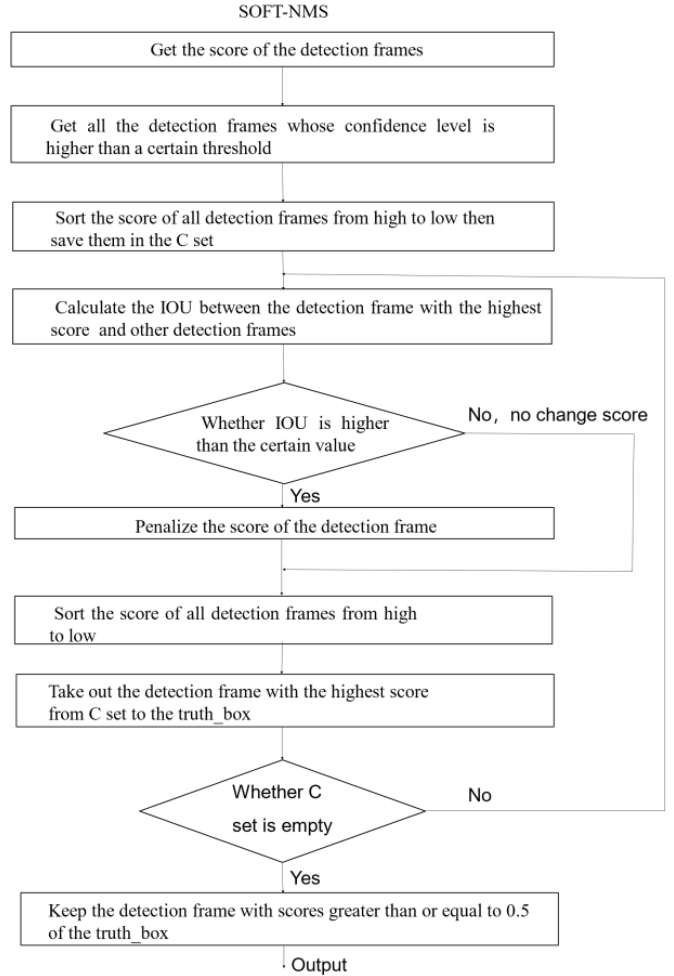
Figure 3. The flow chart of Soft-NMS. In summary, the main idea of Soft-NMS is as follows. Firstly, it finds out all the detection frames which have a higher confidence level than a certain artificial-set confidence level from an image. The circumstance that the confidence level is lower than this certain confidence level means that there is no target object in the detection frame. Secondly, it processes the detection frames that belong to the same category. Finally, it establishes a set B and puts all the detection frames that belong to the same category into this set. The specific algorithm of Soft-NMS is as